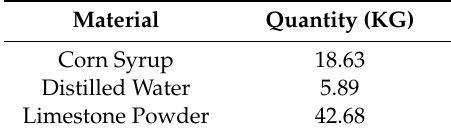
Table 2. Mix design of NIST reference material replicate.